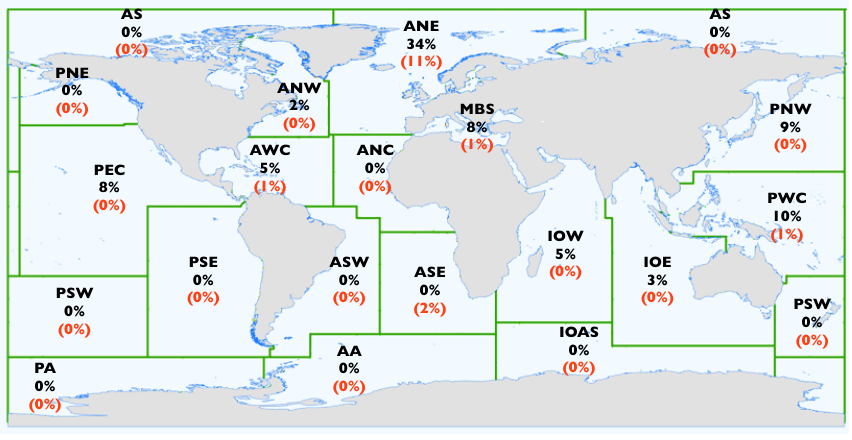
Figure 3. Regional distribution of the organisms and communities investigated, broken down following the Food and Agriculture Orga- nization of the United Nations (FAO) major fishing areas. AS, Arctic Sea; ANW, Atlantic, Northwest; ANE, Atlantic, Northeast; AWC, Atlantic, Western Central; ANC, Atlantic, Eastern Central; MBS, Mediterranean and Black Sea; ASW, Atlantic, Southwest; ASE, Atlantic, Southeast; AA, Atlantic, Antarctic; IOW, Indian Ocean, Western; IOE, Indian Ocean, Eastern; IOAS, Indian Ocean, Antarctic and Southern; PNW, Pacific, Northwest; PNE, Pacific, Northeast; PWC, Pacific, Western Central; PEC, Pacific, Eastern Central; PSW, Pacific, Southwest; PSE, Pacific, Southeast; PA, Pacific, Antarctic. Areas of natural communities, organisms that were collected in these areas shortly before the experiment and coral sampling sites are shown in black while organisms that have gone through many generations are shown in red.